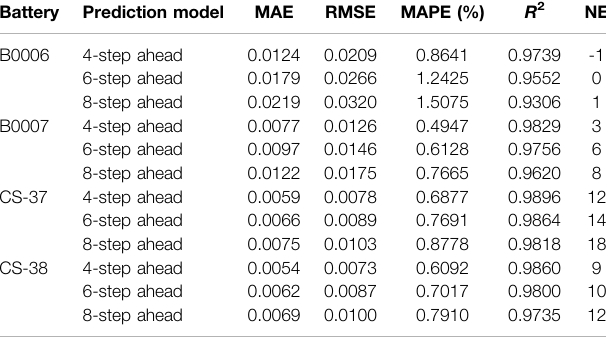
TABLE 5 | Capacity error statistics of the multi-step